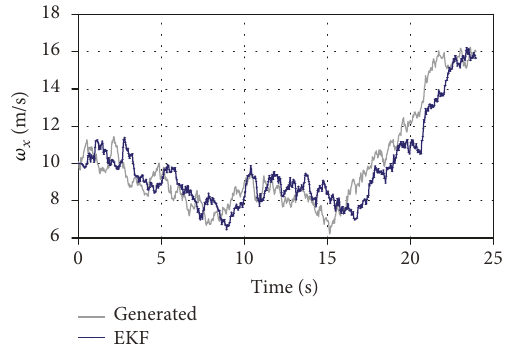
Figure 6: Simulated and estimated horizontal position of ICP-89.